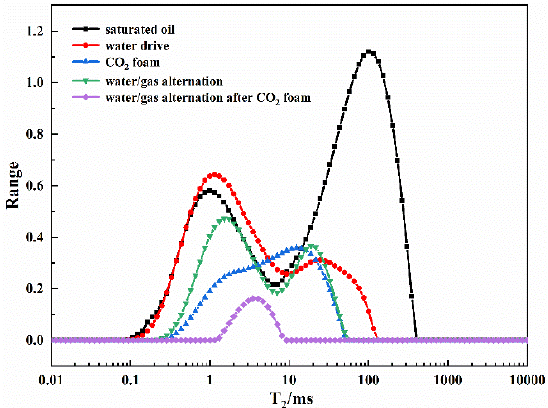
Figure 10. NMR T 2 spectra of different flow control systems in core No. 4.